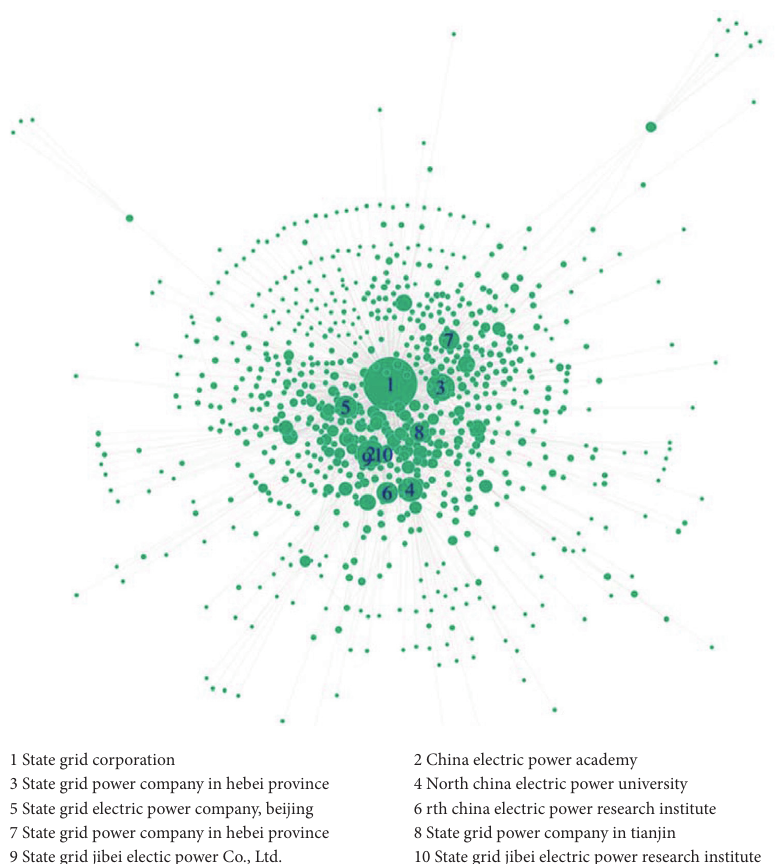
Figure 5: Electric Power Community of Innovation with hierarchical structure. Table 5: Geographical characteristics of communities of innova- tion in BTH Urban Agglomeration. Community